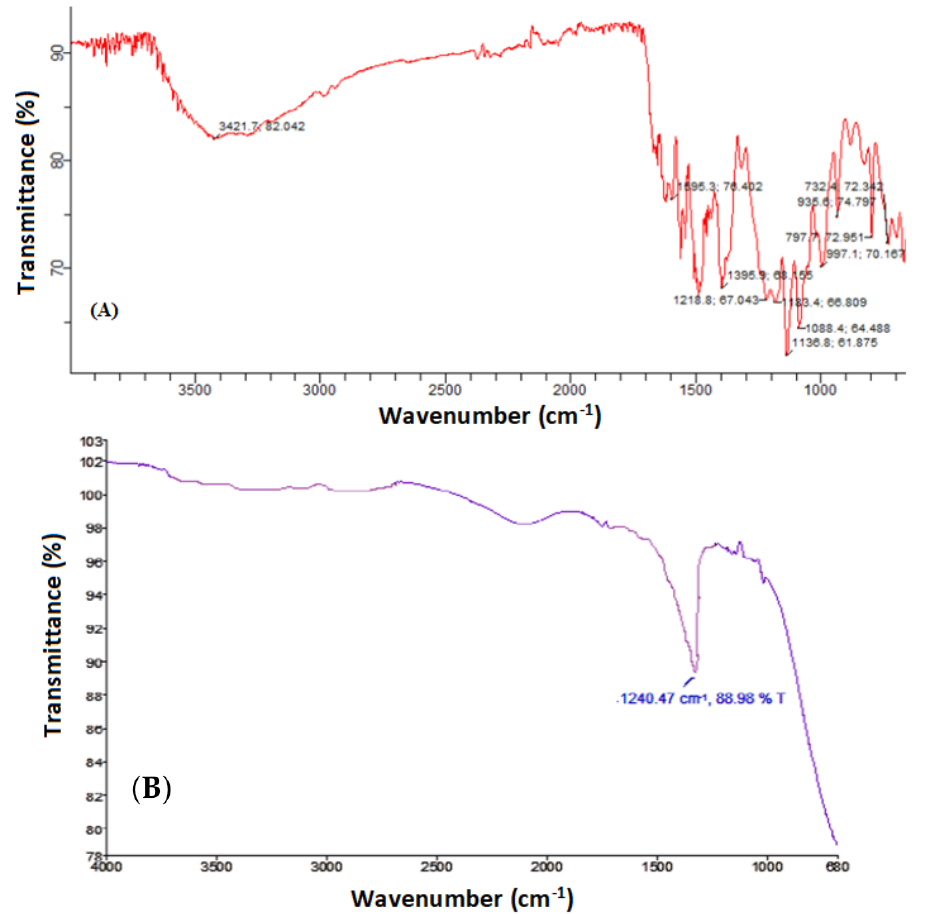
Figure 8. ( A ) FTIR spectrum of Reactive yellow 160A before UV treatment and ( B ) FTIR spectrum of Reactive yellow 160A after treatment (TiO 2 = 450 mg/L, pH = 3, RY-160 = 30 mg/L, irradiation time = 120 min).